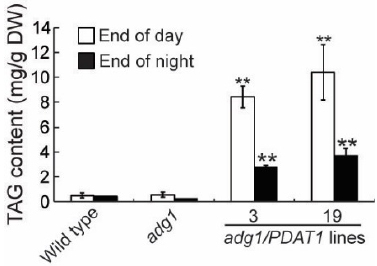
Figure 2. TAG content in leaves of six-week-old plants grown on soil. Asterisks indicate statistically significant differences from adg1 based on Student’s t test ( P < 0.01).